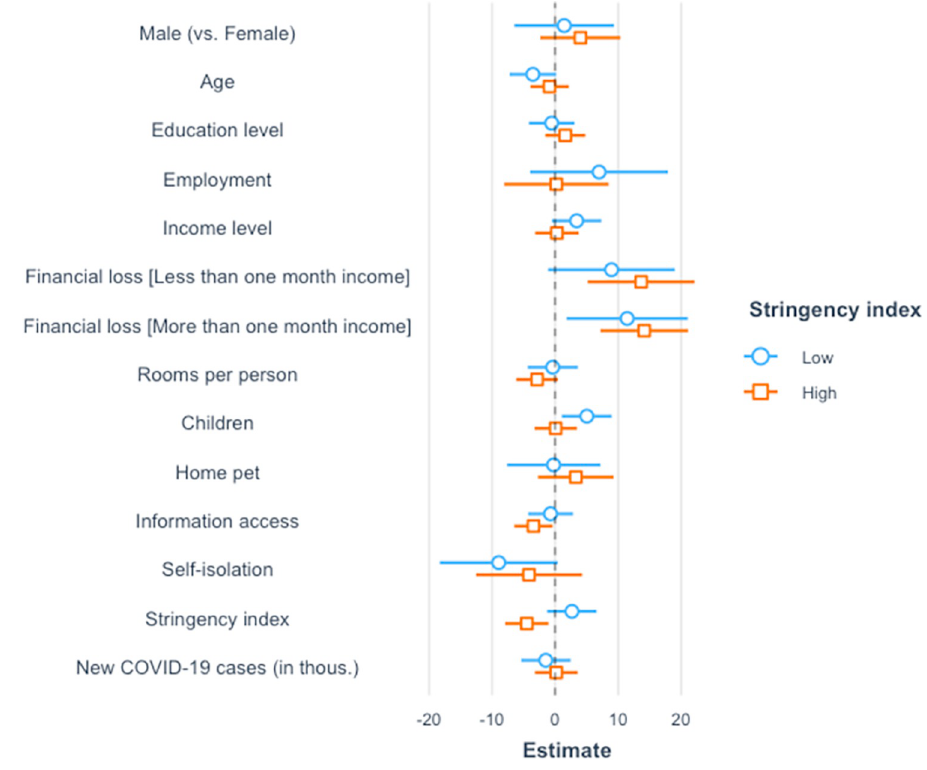
Fig 6. Standardized regression coefficients for stress in groups with different level of stringency index. Standardized regression coefficients with 95% CIs are shown. The confidence interval of the effect estimate should not overlap with zero for the effect to be considered statistically